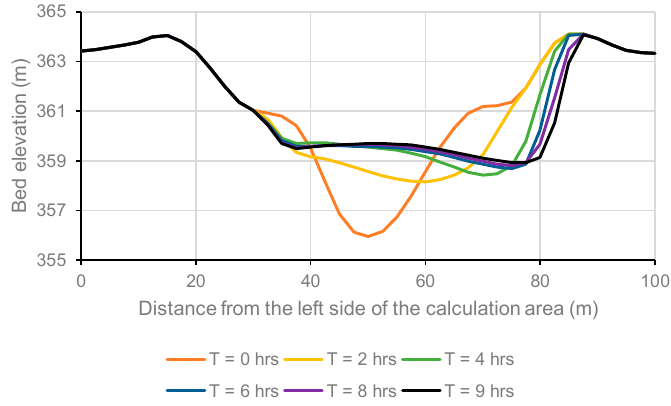
Figure 7. Transverse profile of riverbed elevation at Kyusen Bridge.